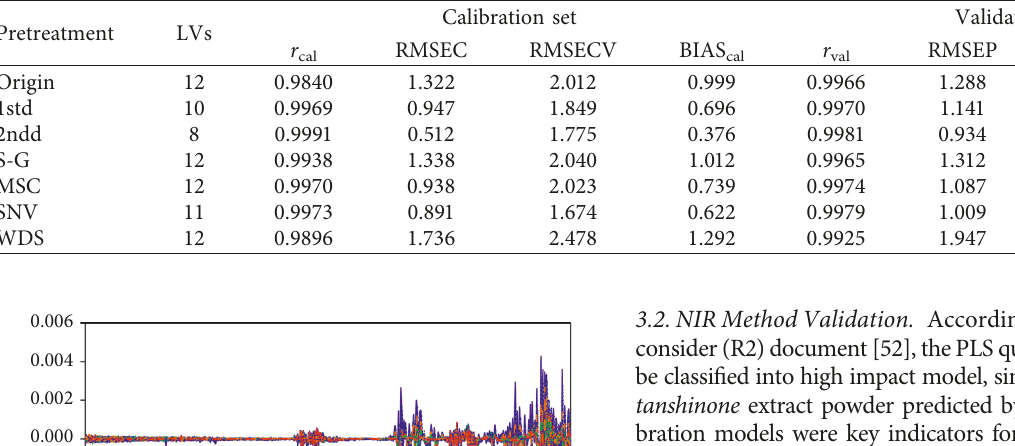
Table 2: PLS model characteristics for tanshinoneII